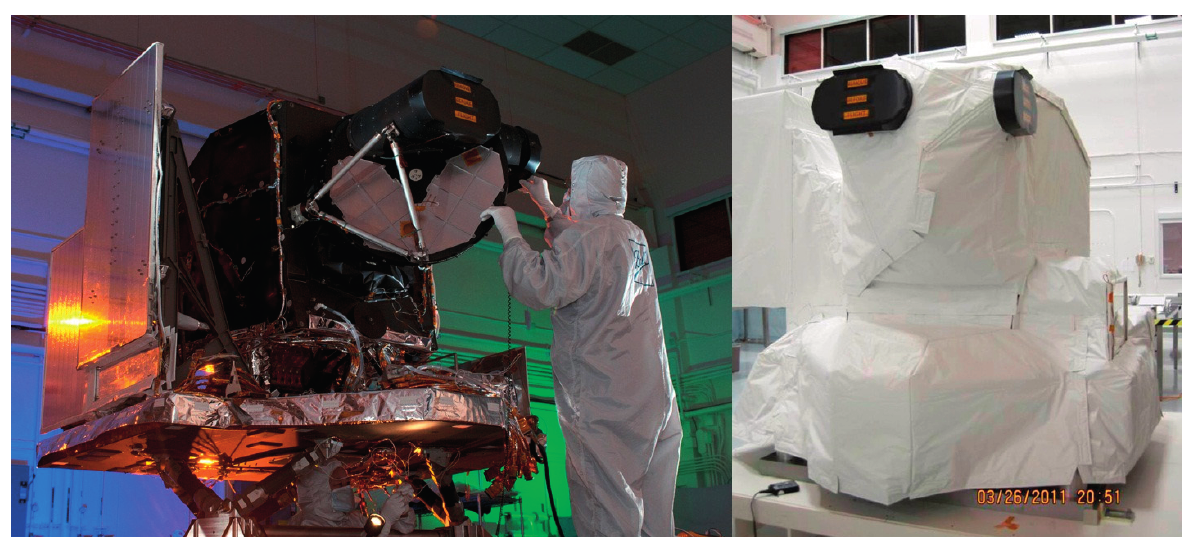
Figure 2. OLI without the thermal blankets ( left ); OLI buttoned up for shipping ( right